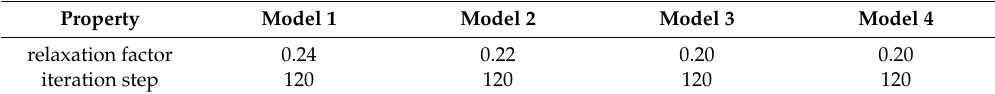
Table 1. Parameters of ART